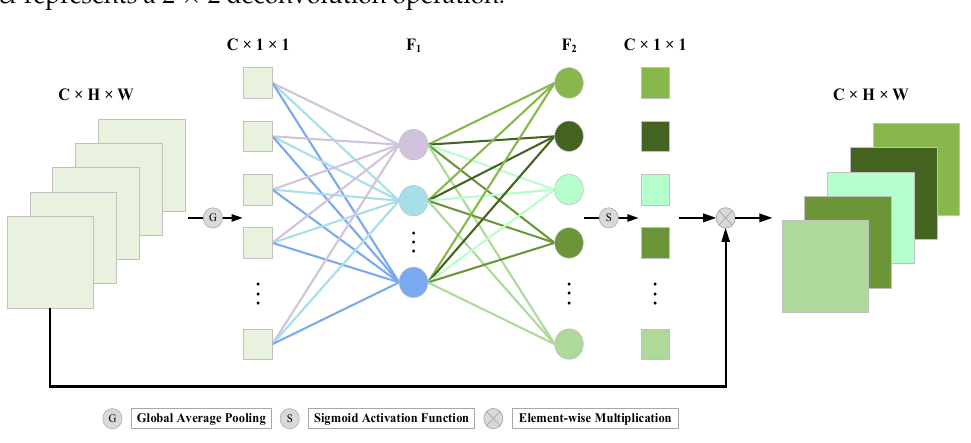
Figure 5. The implementation of the SE attention mechanism. C, H, and W represent the number of channels, height, and width of the input feature map, respectively. F 1 and F 2 are two fully connected (FC) layers.